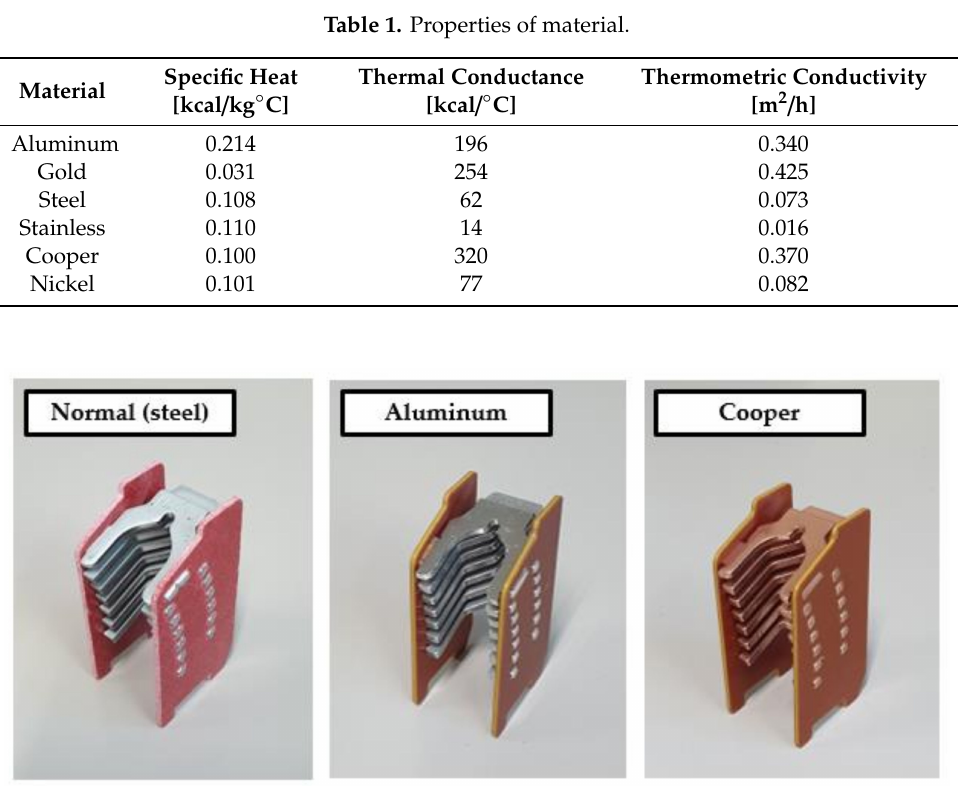
Figure 4. Aluminum and copper splitter